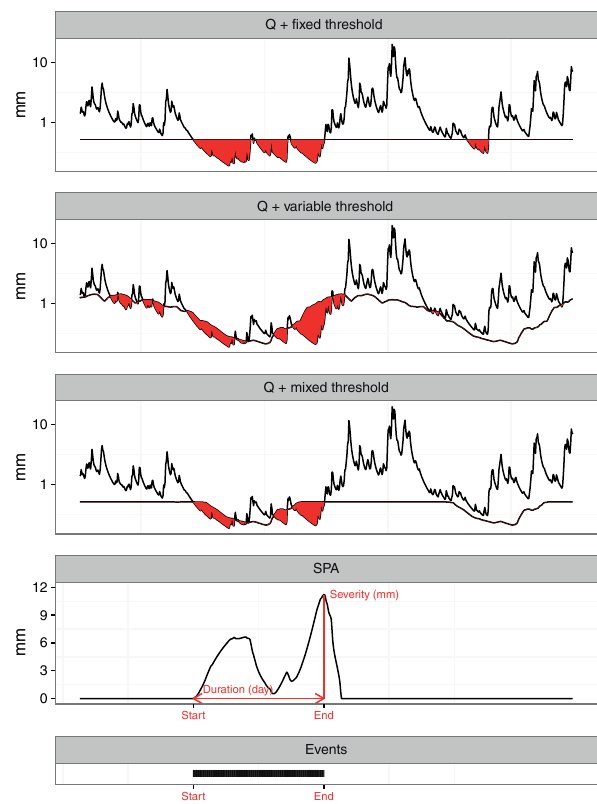
Figure 3. Extreme low-flow event characterization method. First panel: fixed threshold. Second panel: variable threshold. Third panel: mixed threshold. Fourth panel: sequent peak algorithm out- put using a mixed threshold, and extreme low-flow event character- istics. Fifth panel: event definition (start date to end